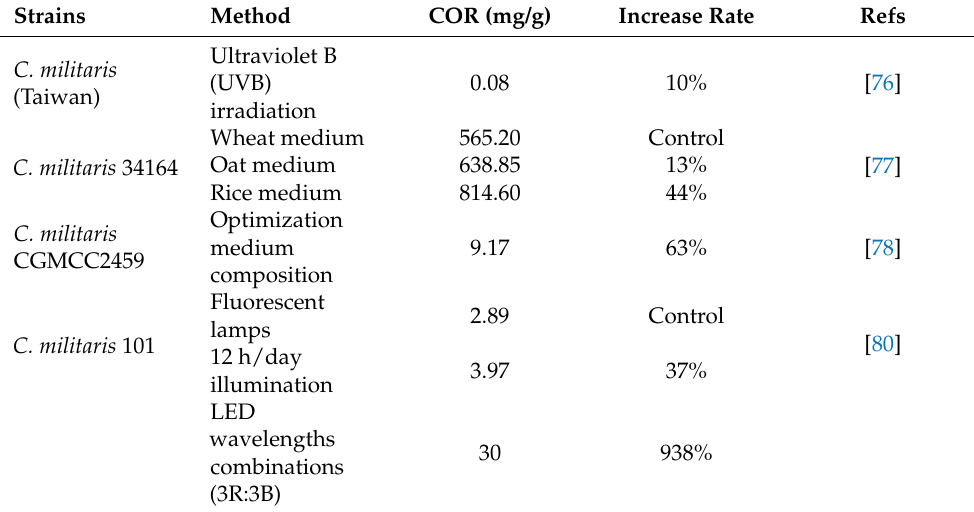
Table 3. Production of COR under different solid-state fermentation (SSF)